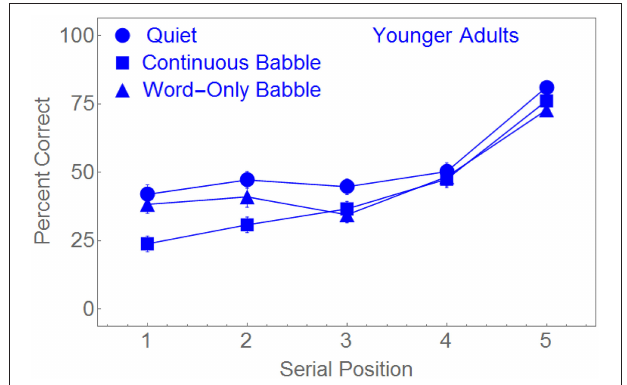
FIGURE 3 | Percent correct word identification as a function of the serial position of the word pair for the younger adults in three different masking conditions. Standard error bars are